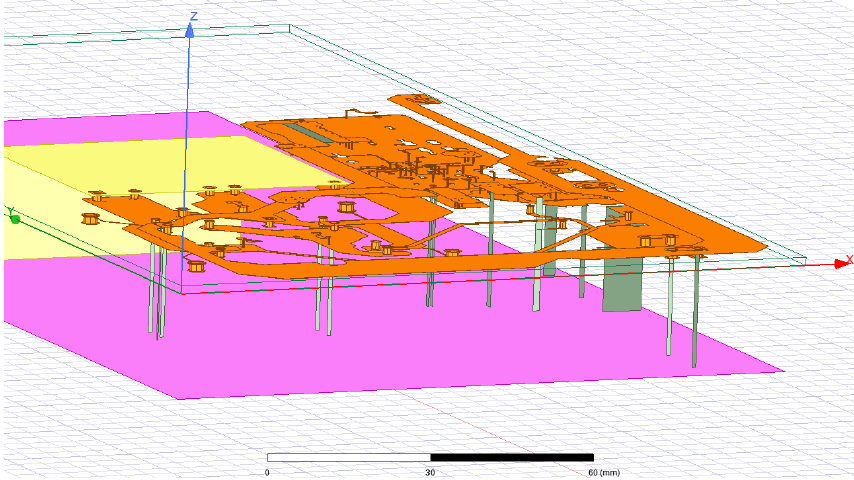
Figure 16. Overview of the ports assigned to the 3D model in HFSS.